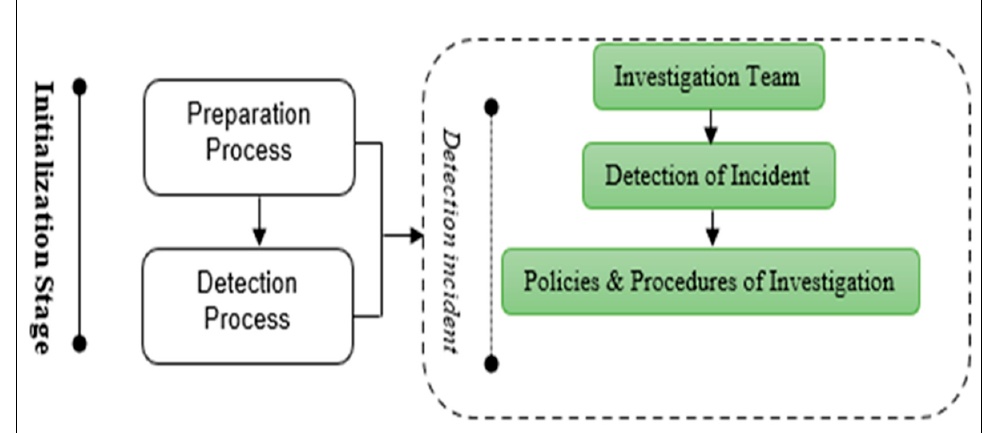
Figure 6. Initialization stage.